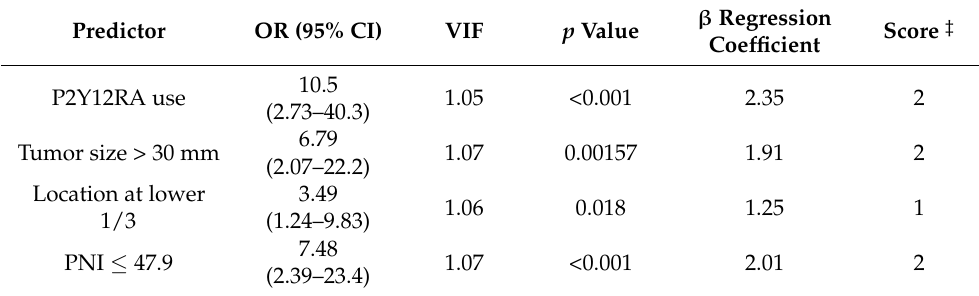
Table 3. Independent risk factors for post-ESD bleeding.